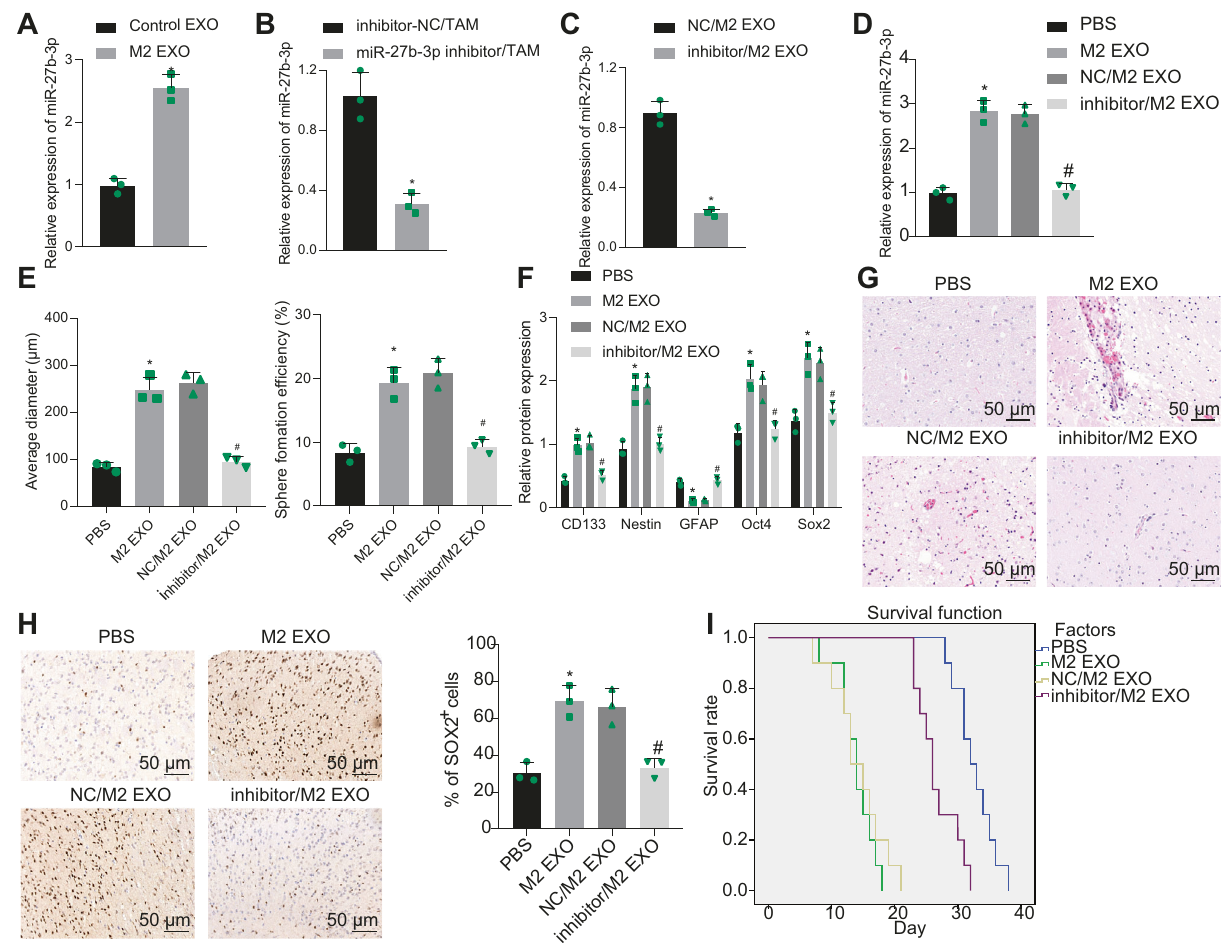
Fig. 3 M2-TAM-derived exosomes containing miR-27b-3p enhance the properties of GSCs. A Expression of miR-27b-3p in M2-TAM-derived exosomes tested by RT-qPCR. B Expression of miR-27b-3p in M2-TAMs transfected with miR-27b-3p inhibitor tested by RT-qPCR. C Expression of miR-27b-3p in exosomes derived from M2-TAMs transfected with miR-27b-3p inhibitor analyzed by RT-qPCR. D Expression of miR-27b-3p in GSCs co-cultured with M2-TAM-derived exosomes. E The formation rate and diameter of spheres in GSCs. F Expression of stem cell-related protein CD133, Nestin, Oct4, Sox2, and GFAP in GSCs measured by Western blot analysis. G HE staining images of xenograft tumors from mice. H The representative immunohistochemical image of Sox2 in xenograft tumors and the percentage of GSC labeled by Sox2. I Kaplan – Meier survive curve of tumor-bearing mice. n = 10. * p < 0.05 vs. the control EXO group, the inhibitor-NC/TAM group, the NC/M2 EXO group, or the PBS group. # P < 0.05 vs. the NC/M2 EXO group. Measurement data were depicted as mean ± standard deviation. Comparison of data between two groups was conducted by unpaired t test, while that among multiple groups by one-way ANOVA followed by Tukey ’ s post hoc test. Cell experiments were repeated three times independently. inhibitor-treated M2-TAM-derived exosomes (Fig. 3E and Supple- Hence, M2-TAM-derived exosomes may be a key paracrine mentary Fig. 1A). Besides, the protein levels of CD133, Nestin, factor contributing to the tumorigenic properties of GSCs. Oct4, and Sox2 were raised, while GFAP level was reduced in GSCs after co-culture with M2-TAM-derived exosomes; however, miR- miR-27b-3p transferred by M2-TAM-derived exosomes 27b-3p inhibitor reversed the effects of M2-TAM-derived exo- potentiates the tumorigenic properties of GSCs somes on the above proteins (Fig. 3F). Exosomal miRNAs have been illustrated as important regulators of After the exosomes and GSCs were delivered into the brain of cellular functions [23]. Recently, miR-27b-3p was highly expressed mice, the observation after HE staining showed that the tumor- in exosomes secreted by M2 macrophages [10]. Of note, miR-27b- promoting effect of GSCs was enhanced by M2-TAM-derived 3p expression was markedly increased in M2-TAM-derived exosomes, but suppressed by the exosomes derived from the miR- exosomes relative to control TAM-derived exosomes (Fig. 3A). 27b-3p inhibitor-treated M2-TAMs (Fig. 3G). The immunohisto- It was veri fi ed that miR-27b-3p expression was diminished in chemical staining presented that the percentage of Sox2-labeled the M2-TAMs transfected with miR-27b-3p inhibitor and their GSCs was increased by the M2-TAM-derived exosomes but it was derived exosomes (Fig. 3B, C). Of note, the miR-27b-3p expression reduced following miR-27b-3p inhibition (Fig. 3H). Additionally, in the GSCs was enhanced by M2-TAM-derived exosomes, while the survival time of mice was shortened by treatment with M2- miR-27b-3p expression in the GSCs was reduced by exosomes TAM-derived exosomes, but prolonged by the exosomes derived from the M2-TAMs that had been transfected with miR-27b-3p from the miR-27b-3p inhibitor-treated M2-TAMs (Fig. 3I). inhibitor (Fig. 3D). Together, M2-TAM-derived exosomes can promote the proper- Moreover, neurospheres formed in GSCs were increased by M2- ties of GSCs by delivering miR-27b-3p. TAM-derived exosomes, but decreased in response to miR-27b-3p